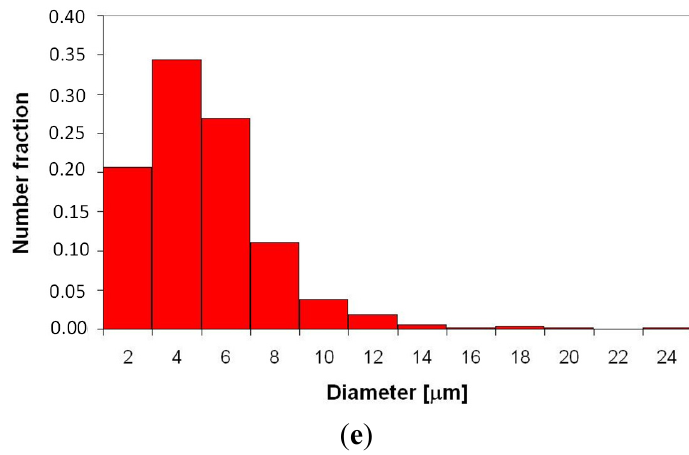
Figure 6. Microstructural characterization with OIM of sample no. 1 after laser deposition: ( a ) EBSD inverse pole figure map; ( b ) phase composition map: red color denotes the L2 1 Fe 2 TiAl Heusler phase, green color denotes the—C14 Fe 2 Ti Laves phase; ( c , d ) high magnification of OIM maps showing the distribution of the C14 Laves phase (green) in the L2 1 matrix (red color); ( e ) the grain size distribution of the L2 1 Fe 2 TiAl phase. After annealing at 1000 °C for 20 h in an argon atmosphere with furnace cooling, sample no. 1 exhibited a coherent microstructure of the ordered L2 1 -phase and some amounts of the disordered A2 phase and the C14 Laves phase, which predominantly precipitated along the grain